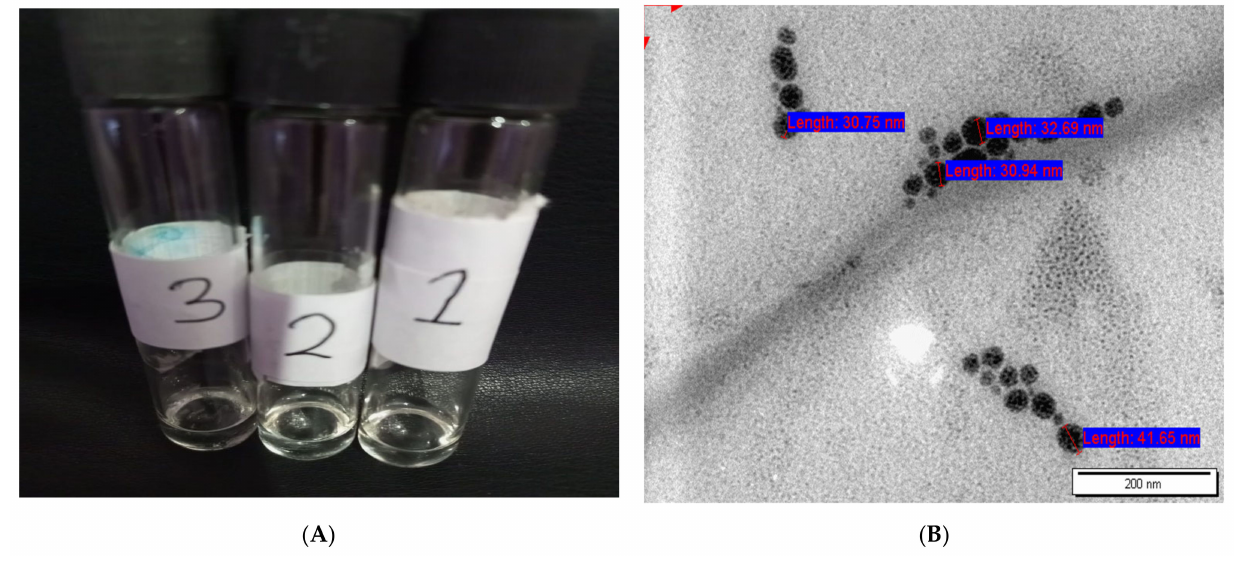
Figure 2. ( A ) Three samples (1, 2, and 3) of prednisolone microemulsion 7 (PRD-ME 7) after being subjected to thermodynamic stability studies showing no precipitation or phase separation and ( B ) Transmission electron microscope (TEM) image of PRD-ME